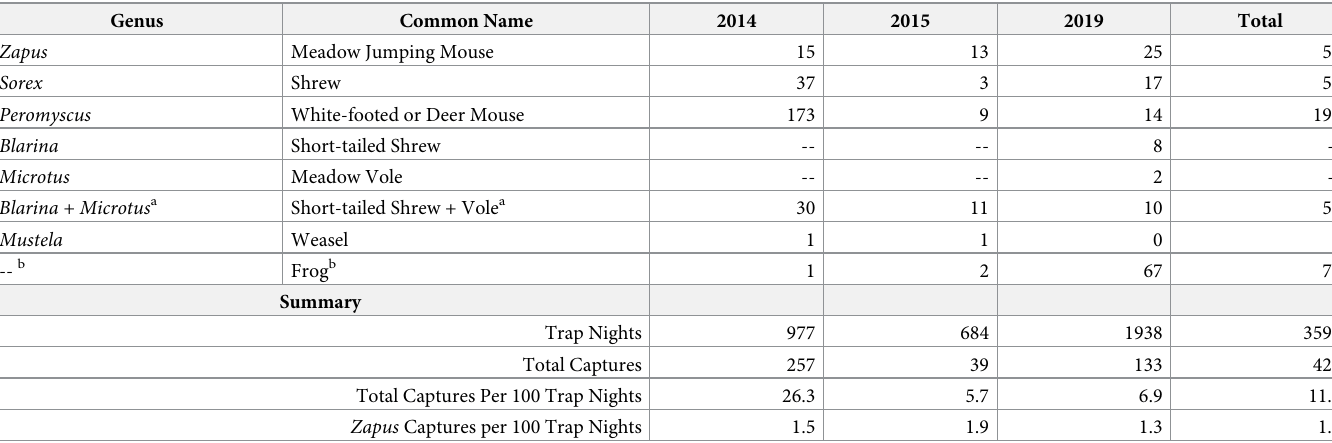
Table 1. Species captured during three years of Zapus